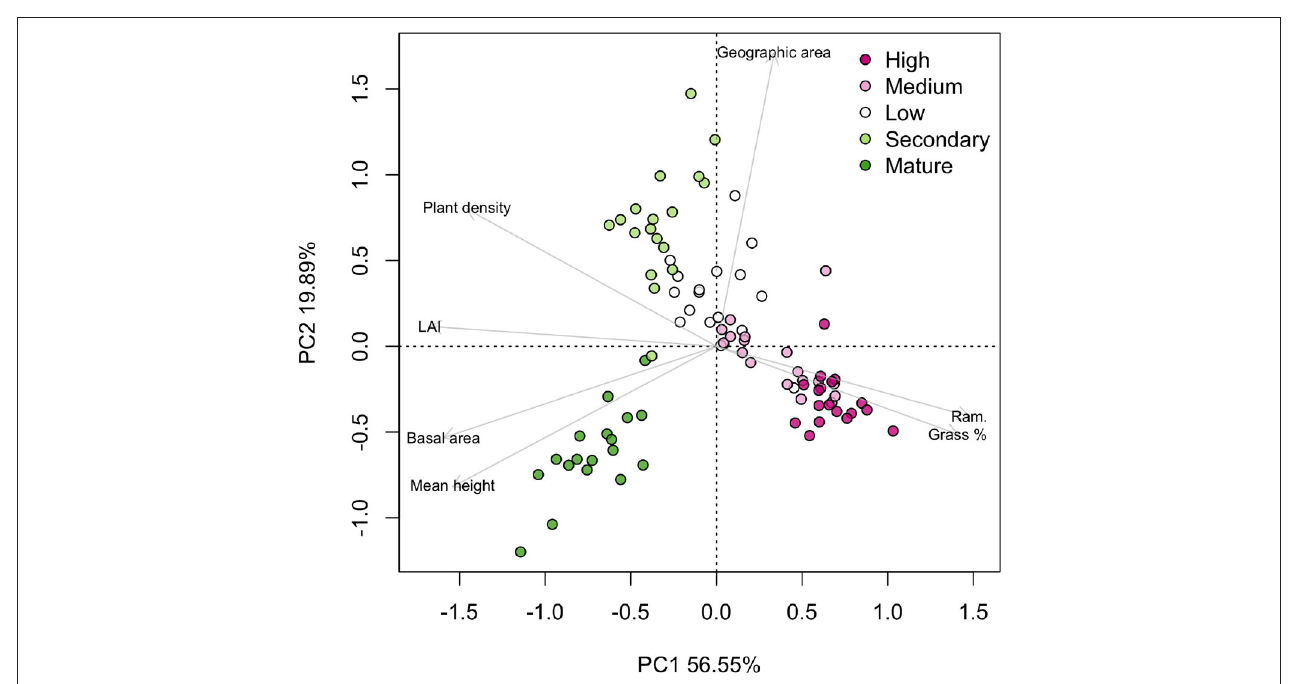
FIGURE 3 | PCA of the structural parameters along a fire gradient that combines an increasing number of fire events and less time for recovery. High disturbance: four fire events and 0.5 years post-fire. Medium disturbance: three fire events and 8 years post-fire. Low disturbance: one fire event and 20 years post-fire. Secondary forests: no fire events and at least 36 years of regeneration. Old-growth forests, no fire events and they were confirmed forests since 1956 (at least 54 years of regeneration but possibly more). Each point represents a 10 × 10 m subplot in three plots per area ( n = 90). High percent grass cover and plant ramification characterized the areas with harsher fire regimes. Plant density, LAI, basal area, and mean canopy height increased with milder fire regimes. Mature reference forest had the highest basal area and mean canopy height. Large species geographic distribution areas separated the secondary forests from the rest of the